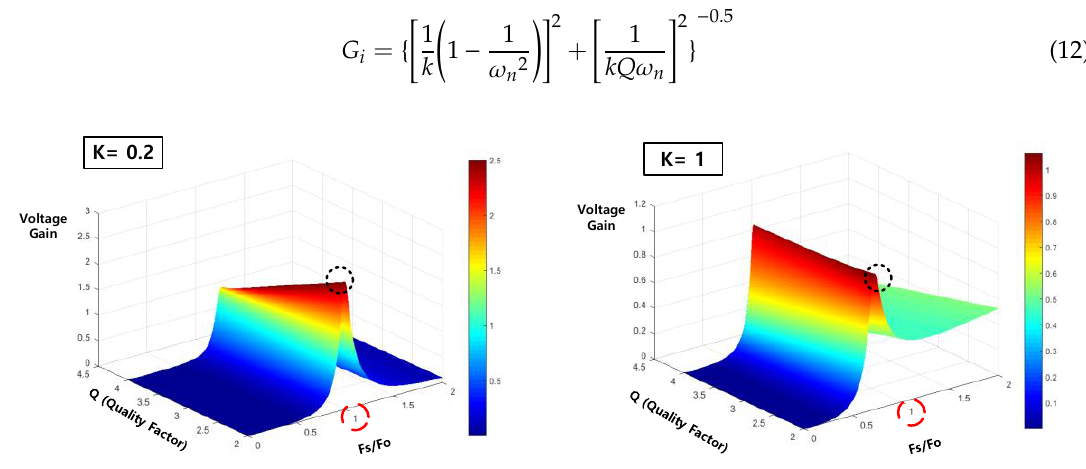
Figure 2. Voltage gain 𝐺 𝑣 according to load quality factor and 𝜔 𝑛 (K = 1, K = 0.2).